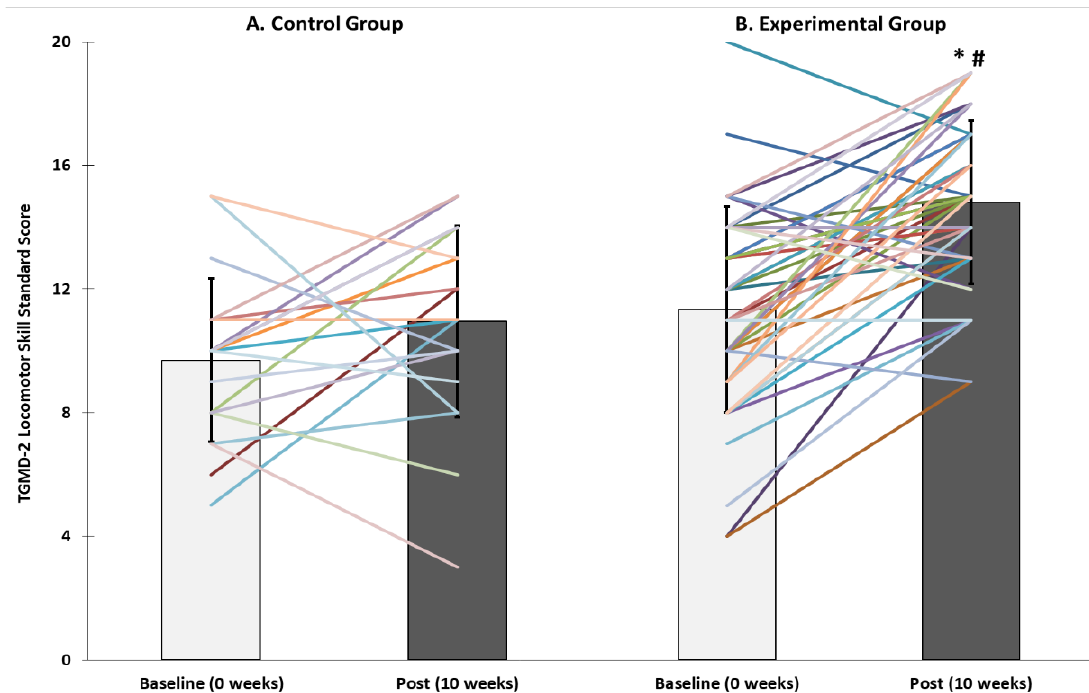
Figure 1. Test of Gross Motor Development (TGMD-2) locomotor skill standard scores pre-and post-intervention in ( A ) Control ( n = 20) and ( B ) Experimental ( n = 46) groups. * Significantly higher than baseline ( p < 0.05). # significantly higher than control group ( p < 0.05).